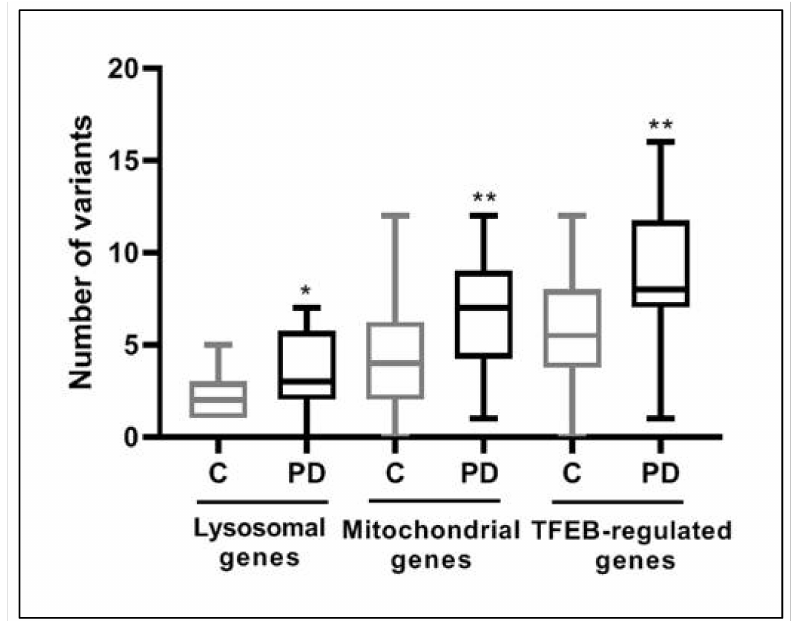
Figure 3. Number of variants carried by PD patients and control individuals for each group of genes.